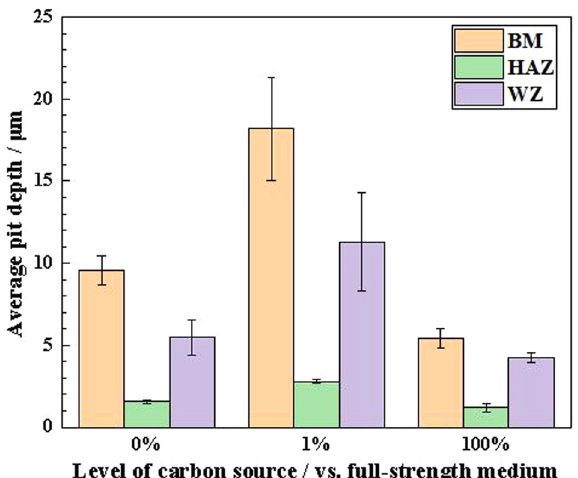
Fig. 7 Average pit depth of welded joints after 30 d immersion. The fi gure shows the average pit depth of BM, HAZ, and WZ for the welded joints after the 30d immersion in different organic carbon source medium (error bars stand for the standard deviations from three independent sample).